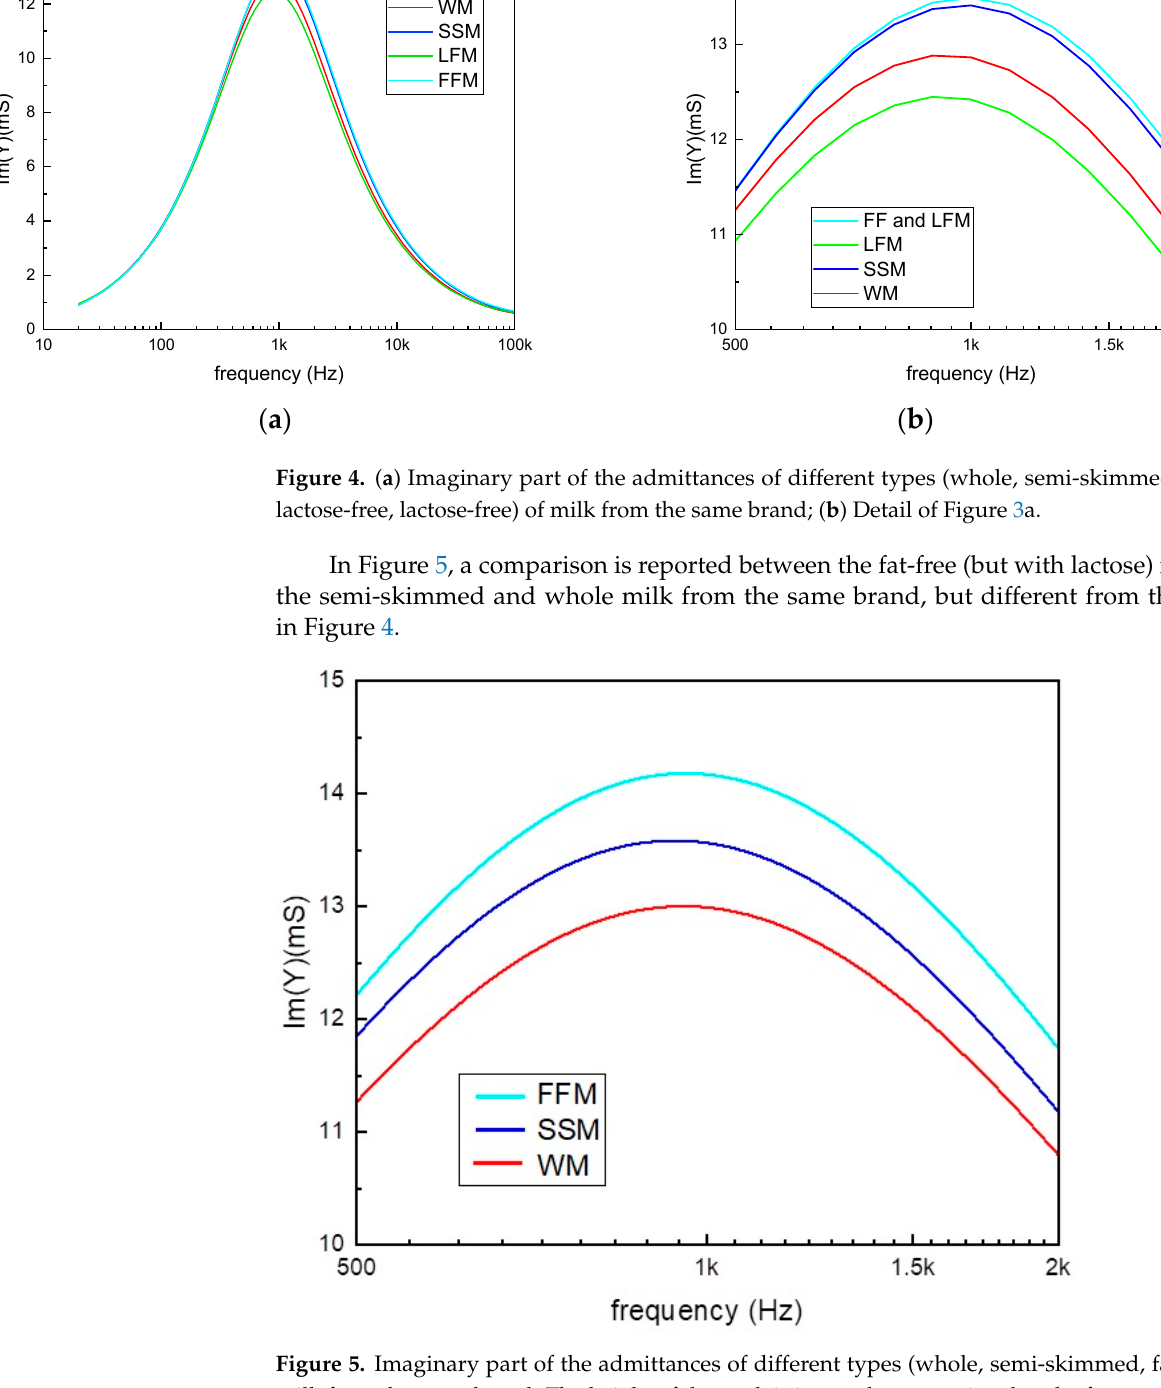
Figure 5. Imaginary part of the admittances of different types (whole, semi-skimmed, fat-free) of milk from the same brand. The height of the peak is inversely proportional to the fat content.